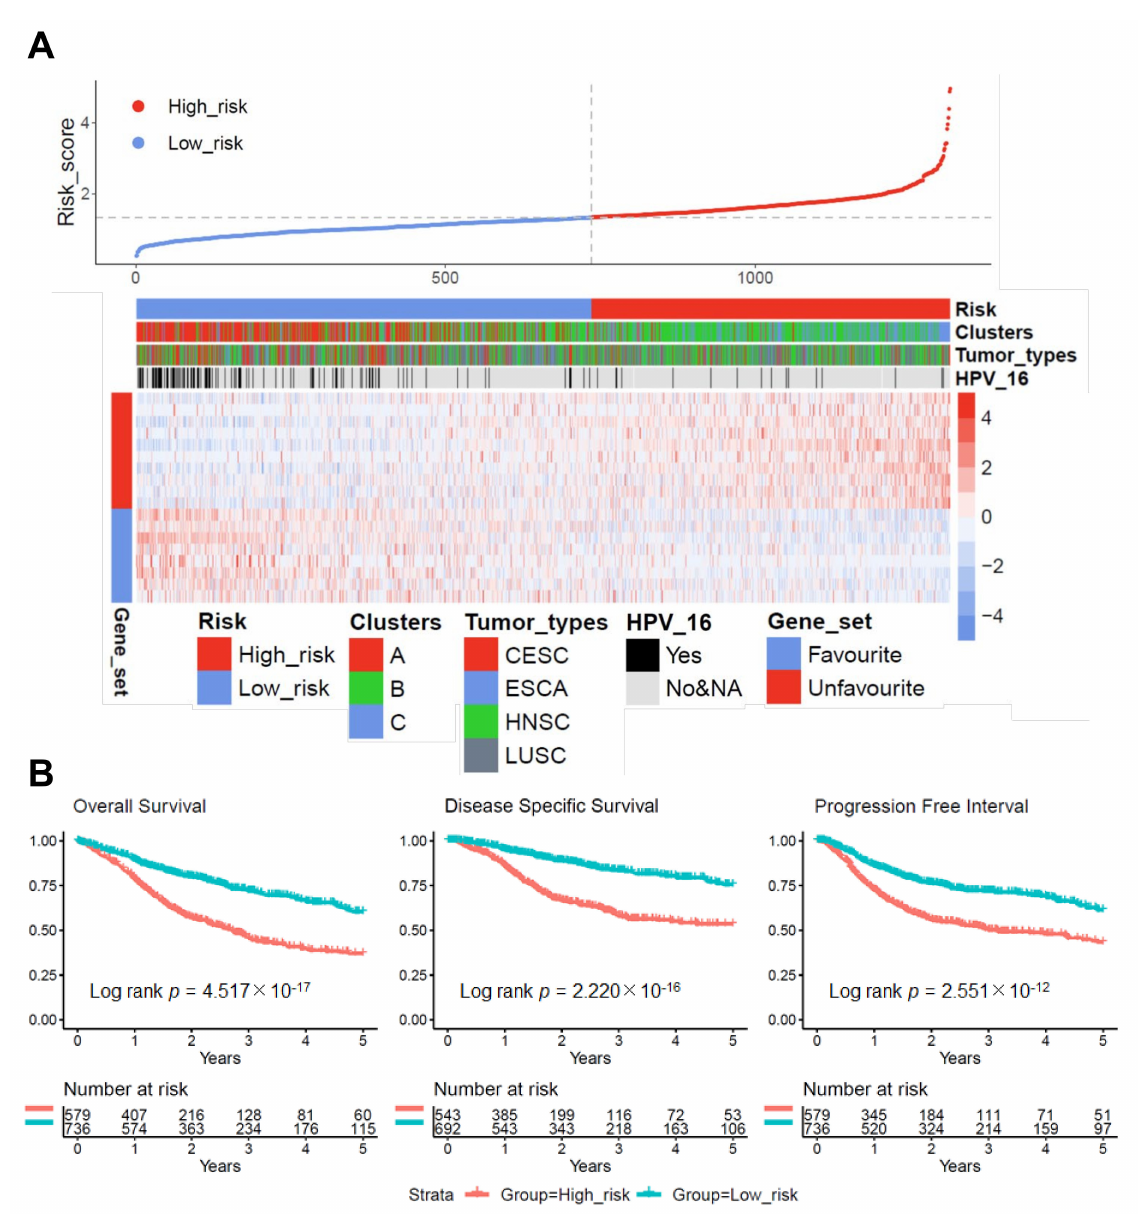
Figure 2. LASSO Cox regression model for the pan-SCC cohort. ( A ) Dot plot displays risk scores for low-risk (blue dots) or high-risk (red dots) subgroups, and the heatmap summarizes expression of 18 prioritized candidate genes within the pan-SCC cohort. ( B ) Kaplan–Meier plots for five-year OS (left), DSS (middle), and PFI (right) of the low-risk and high-risk subgroups for the pan-SCC cohort. p -values were computed by the log-rank test and numbers represent cases at risk for the indicated time